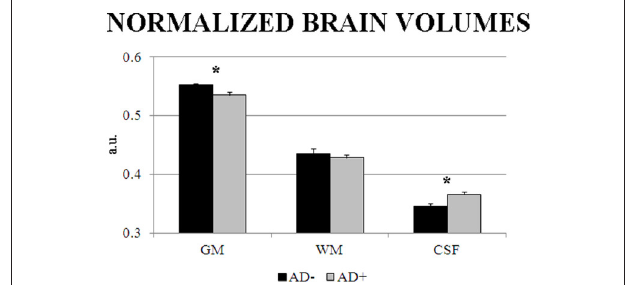
FIGURE 7 | Mean and SD -values of cortical gray matter (GM), subcortical white matter (WM), and cerebrospinal fluid (CSF) normalized volumes as indexes of brain structural integrity extracted by magnetic resonance imaging (MRI) in a subpopulation of 39 AD patients having MRI data associated to EEG recordings. The values are reported in the AD subgroup negative to the EEG marker (AD − ; n = 12) and in the AD subgroup positive to the EEG marker (AD + ; n = 27). These values refer to an ANOVA design showing a statistically significant interaction [ F (2 , 74) = 3.3761, p < 0.05] between the factors Group (AD − , AD + ) and Volume (GM, WM, CSF). Asterisks indicate the p level of the statistical differences between the two AD subgroups obtained by Duncan post-hoc